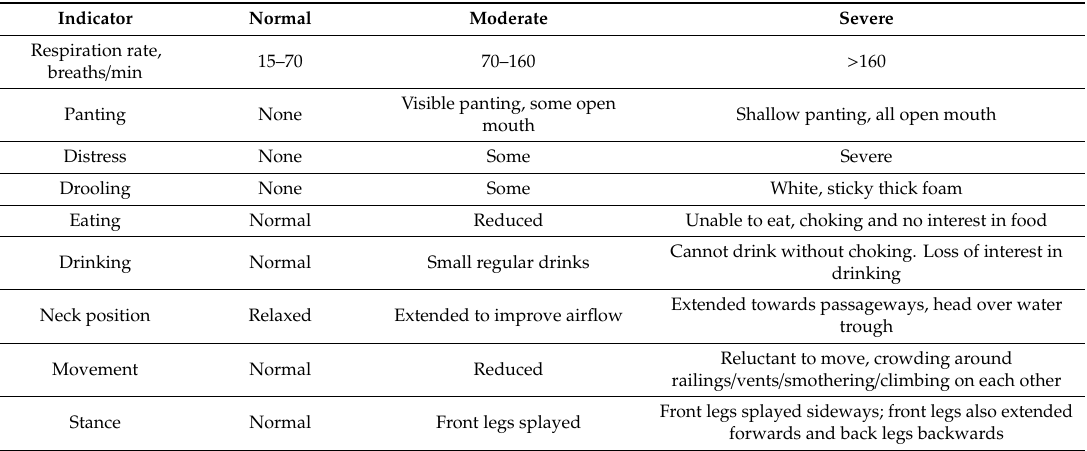
Table 2. Physical indicators of heat stress in sheep in the three-point scale used by ship veterinarians to score sheep daily on each